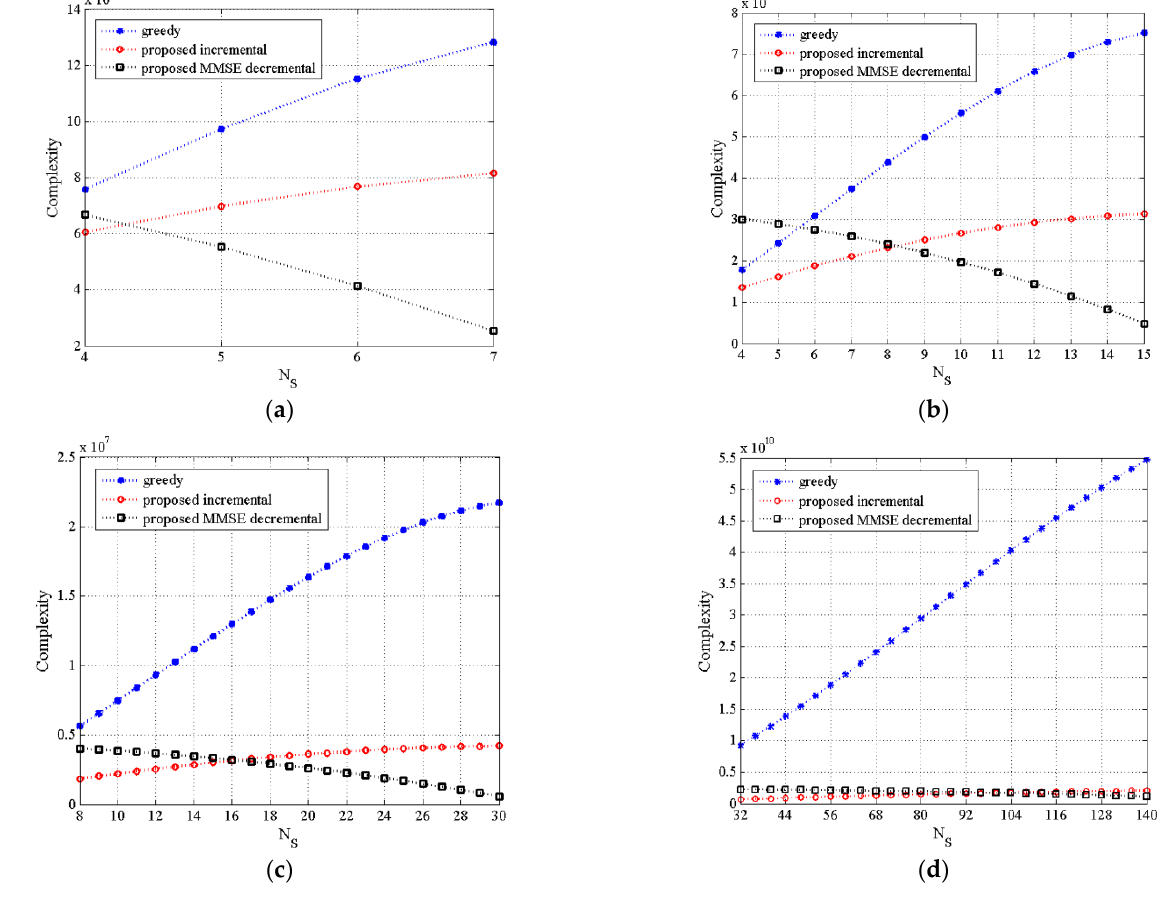
Figure 2. The complexity of the proposed TAS selection algorithms as a function of N S for ( a ) ( 8, N S ,4 ) , ( b ) ( 16, N S ,4 ) , ( c ) ( 32, N S ,8 ) , and ( d ) ( 200, N S ,32 ) MU–STLC